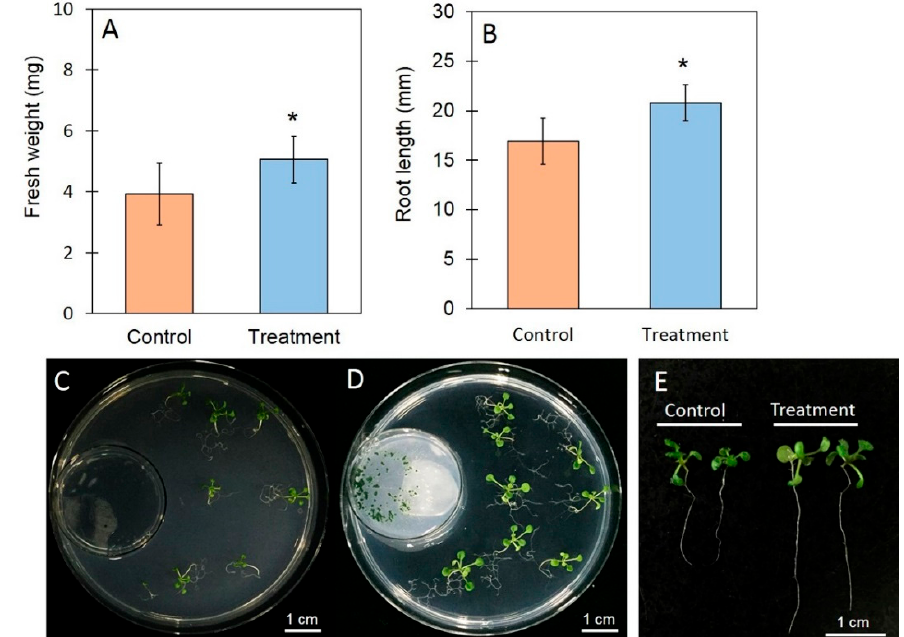
Figure 3. Phenotypic characteristics of Arabidopsis thaliana : Fresh weight ( A ) ; root length ( B ) ; control A. thaliana exposed to plain PDA ( C , E ) ; A. thaliana exposed to T . asperelloides PSU-P1 VOCs ( D , E ). Asterisks indicate statistically significant differences (* p < 0 . 05) using the Student’s t - test .